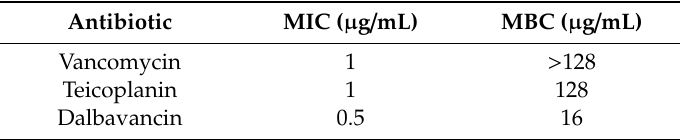
Table 1. Minimum inhibitory concentration (MIC) and minimum bactericidal concentration (MBC) of the three glycopeptide antibiotics used in this study towards S. aureus ATCC 6538P. Values represent the average of data from at least three independent experiments.